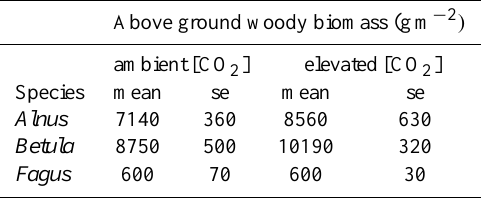
Table 1. Above ground woody biomass after 4 years of free atmo- spheric CO 2